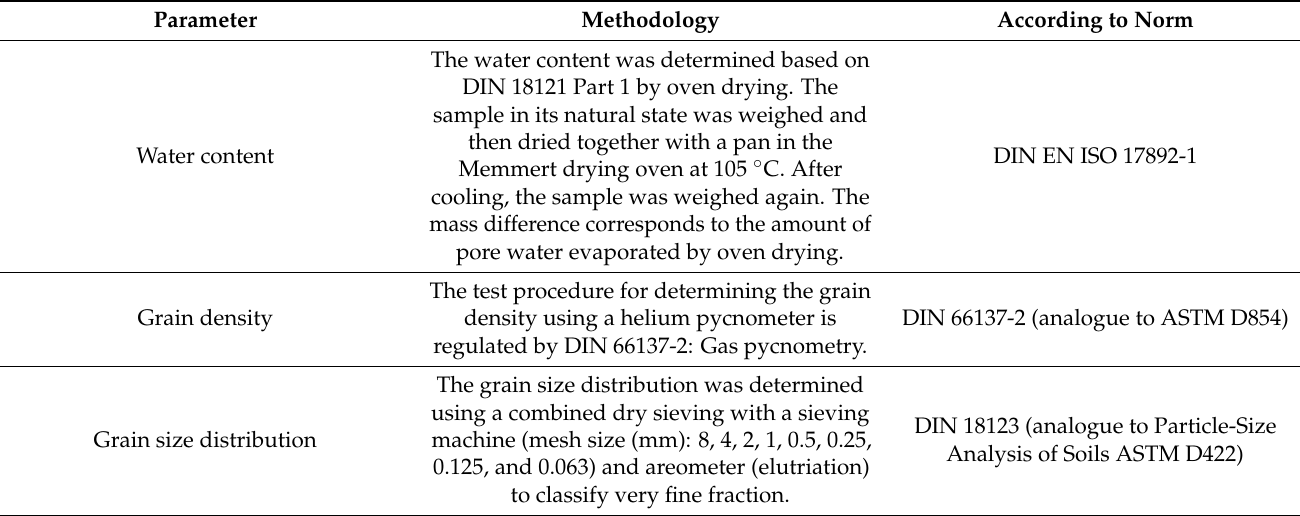
Table 2. DIN norms applied for the soil mechanical lab tests. Parameter Methodology